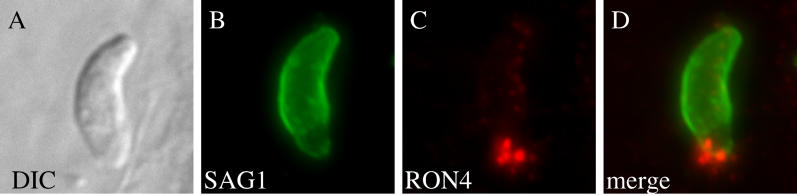
RON4 localization in ΔAMA1/AMA-myc Tachyzoites Following Tetracycline Repression and Abortive InvasionDIC (A) and deconvolution IIF (B–D) were used to image formaldehyde-fixed cultures. Images represent a projection through ten 0.2-μm sections. Intracellular ΔAMA1/AMA-myc tachyzoites were grown in Atc-containing media for 30 hr, syringe-released and then synchronized for invasion using a potassium shift as described in the methods. After allowing invasion for 20 min, the cover-slips were fixed and processed for IIF without detergent permeabilization. SAG1 staining ([B] FITC) shows an extracellular parasite in contact with the HFF monolayer. (C) shows the RON4 (Texas Red staining). (D) is a merge of (B) and (C).